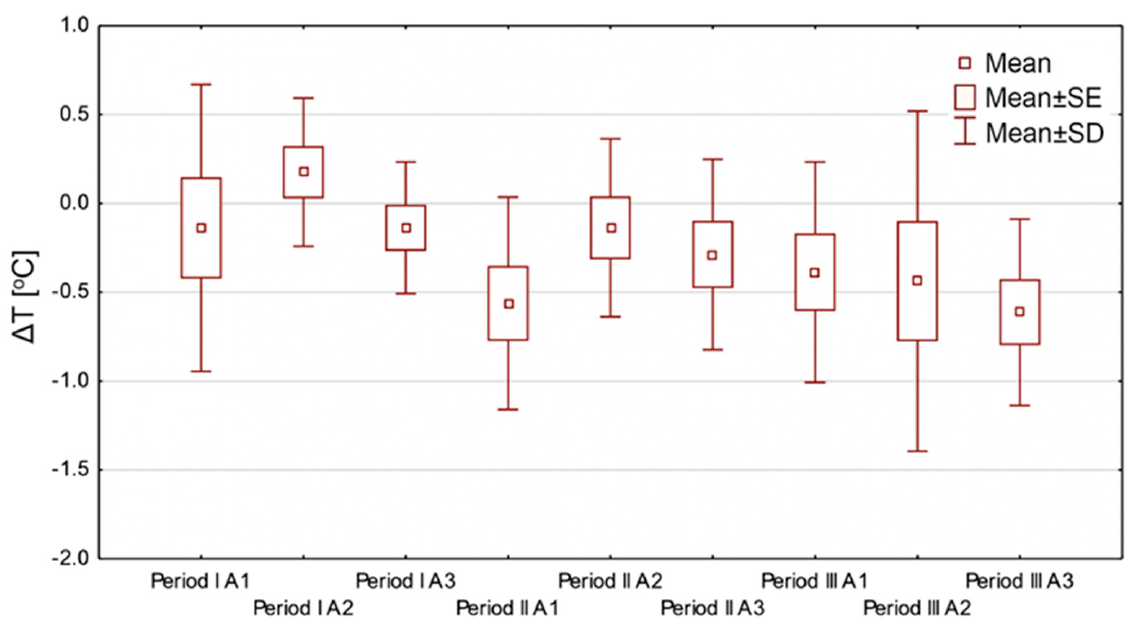
Figure 5. Summary graph showing differences in mean temperature values (SE—standard error; SD—standard deviation) for all studied areas before and after THBOT treatment, in all three treatment periods for all patients, where ∆ T is defined as (T mean after THBOT-T mean before THBOT).